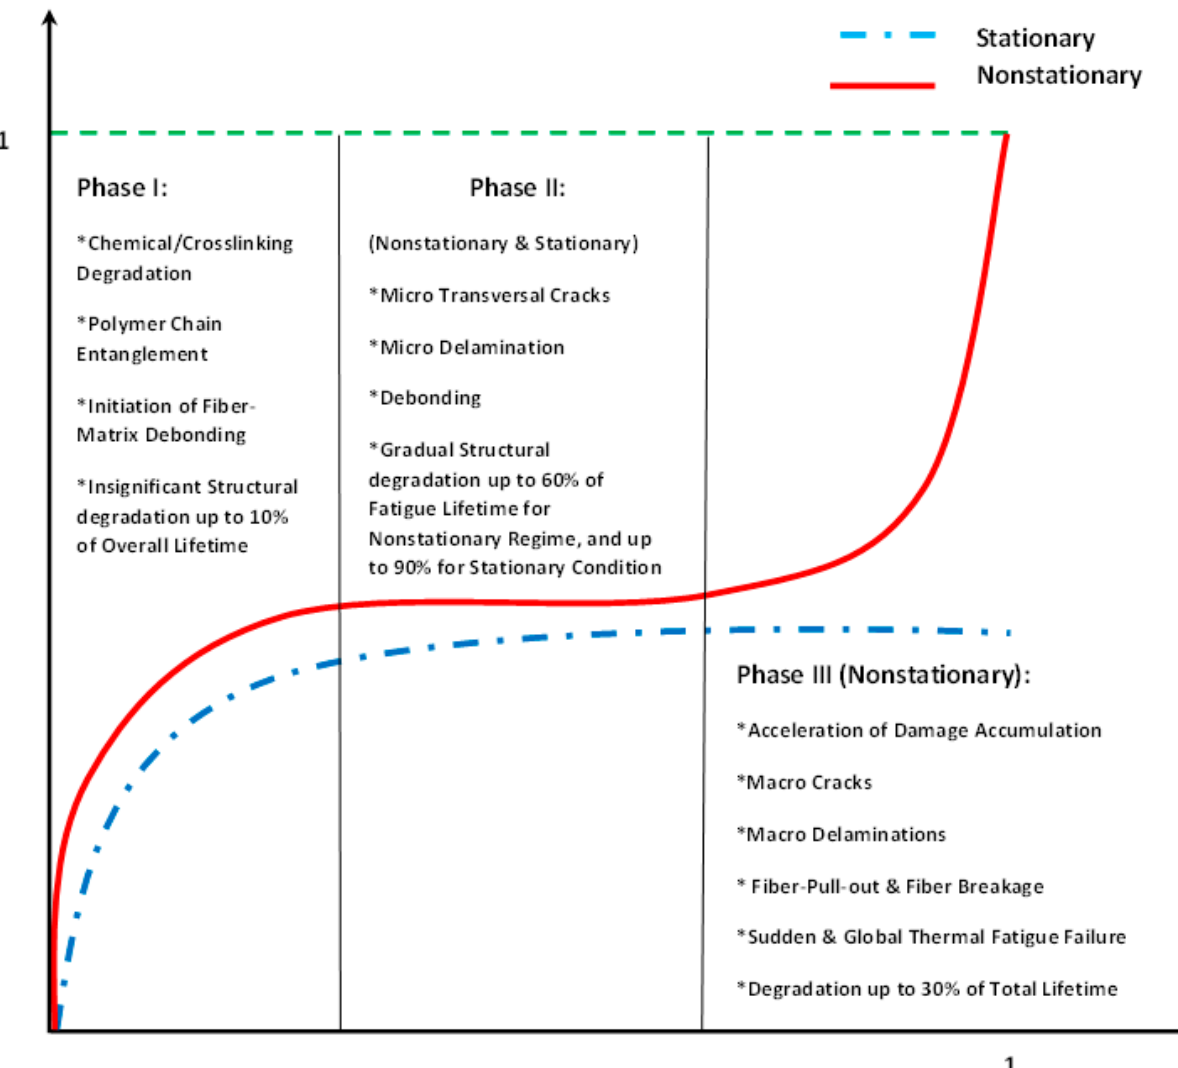
Figure 24. A schematic process of fatigue damage propagation in both stationary and nonstationary self-heating regimes.